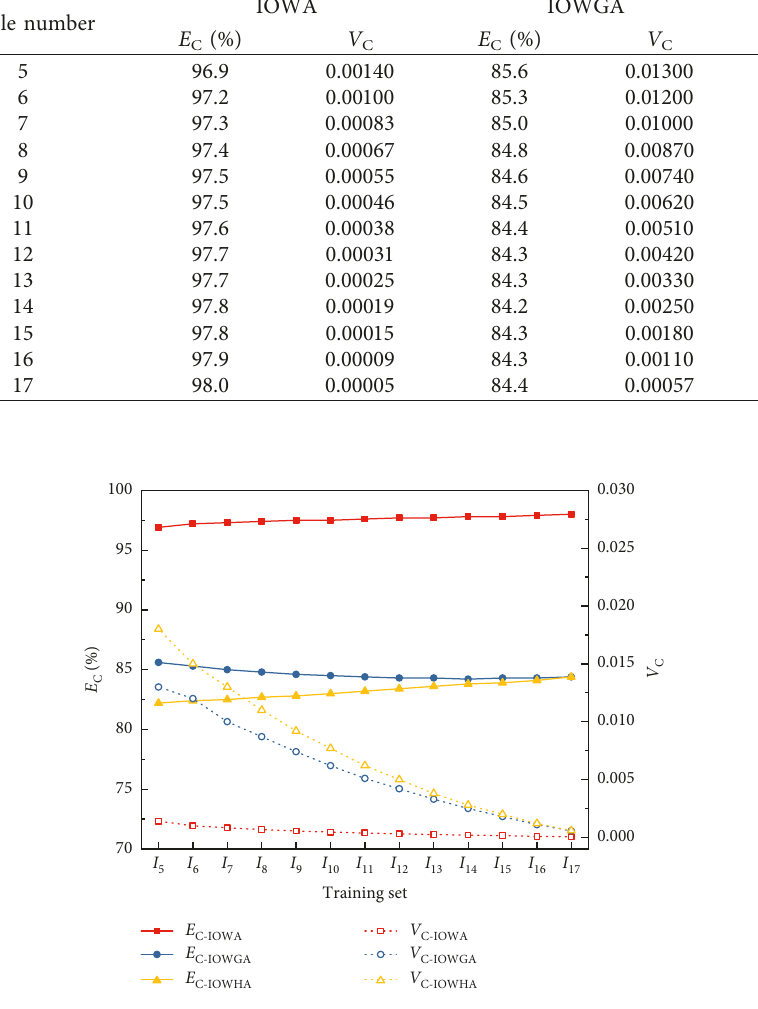
Figure 13: Curves of E C and V C of training sets.